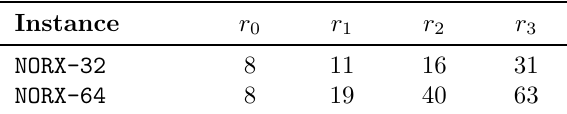
Table 1: Rotation constants in the permutation G